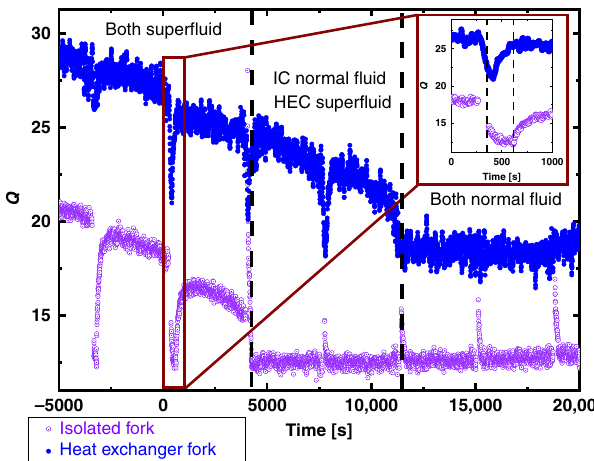
Fig. 6 Quality factor ( Q ) of both forks near T c . The Q as a function of time for the two forks (purple IC, blue HEC) near T c taken at 0 bar. Pulses applied were separated by 60 min and the nuclear stage was warmed up at a constant rate around 10 μ K ⋅ h − 1 . When both the IC and HEC are in the super fl uid state ( fi rst three pulses) a strong, and unexpected, response is seen in Q HEC . As the IC passes through its T c , the third pulse applied evokes a response in Q HEC . Even when the IC is in the normal state (the response in Q of pulse 4 is reversed), a strong response is seen in Q HEC . Only when both the HEC and IC are in the normal state (pulses 5 – 7) is there no anomalous response seen in Q HEC to a heat pulse in the IC. The inset shows details of the second pulse. The fi rst dashed line marks the end of the pulse applied to the IC and the second dashed line marks where the IC, which was heated into the normal state by the pulse, passes through T c . The HEC fork response is maximum at the end of the pulse applied to the the thermal conductivity increases before plateauing at approxi- mately twice its value at T c , similar to the predicted behavior that constant, depending on the choice of scattering parameter. Of